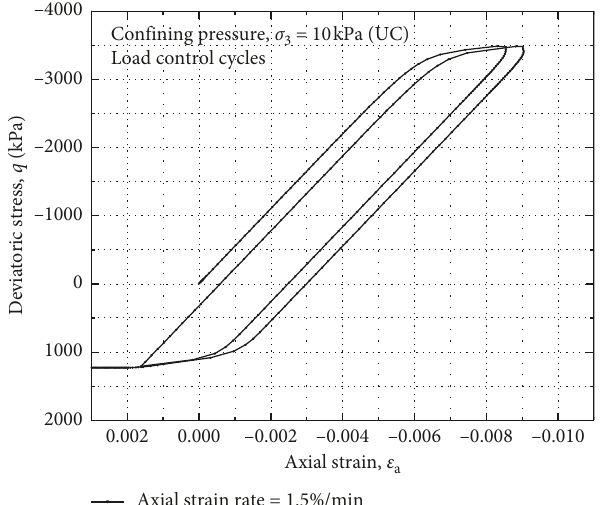
Figure 11: Deviatoric stress versus axial strain for single strain rate under a single confining stress of 10kPa. Load control cyclic analysis is done in both compression and extension